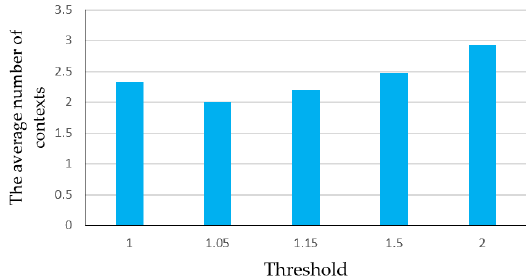
Figure 12. The average number of needed contexts with different thresholds.